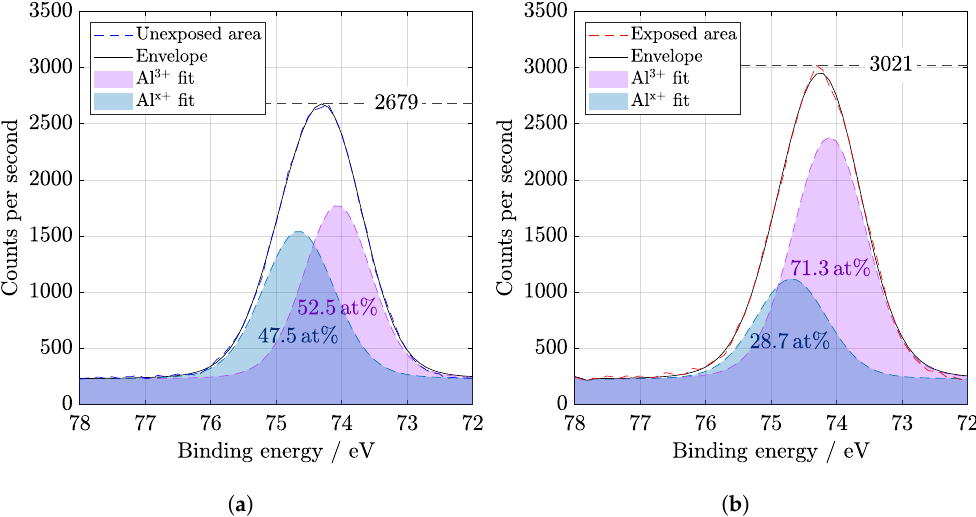
Figure 8. High resolution of Al2p region from XPS ( a ) before and ( b ) after SL irradiation of 67 days. Binding energy value for Al 3 + is 74.1 eV and for Al x + is 74.6 eV. Displacement of the Al peak indicates the degradation of the thin